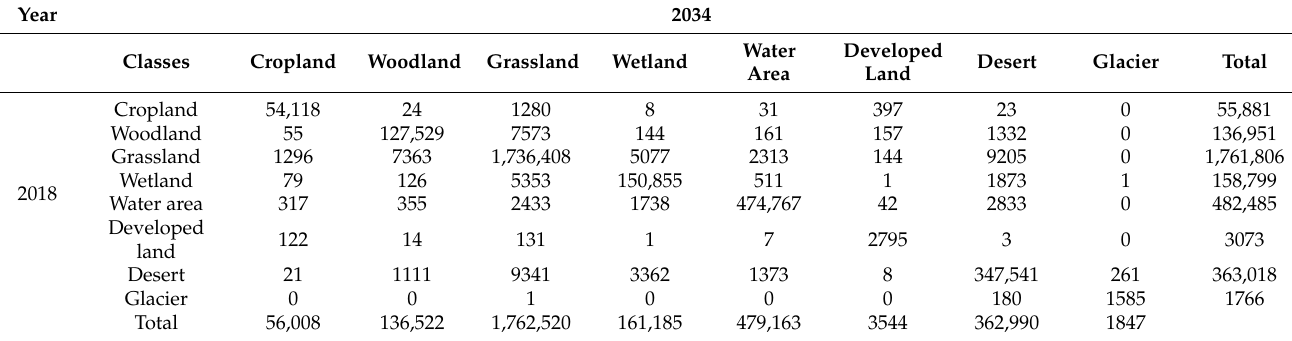
Table 8. Transition matrix of landscape types in the QLB from 2018 to 2034 ( × 10 4 m 2